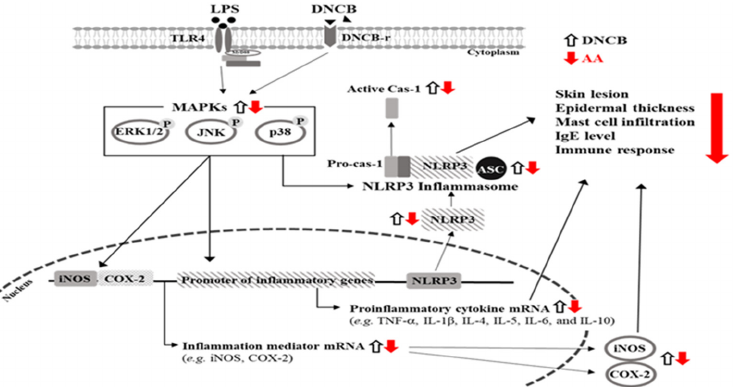
Figure 15. Suggested mechanism for mitigation effects of AA in AD. In this scheme, the treatment of AD is thought to ameliorate the enhancement of skin thickness, dermatitis score, immune organ weight, IgE concentration, and mast cell infiltration through the regulation of iNOS-induced COX- 2 mediated pathway and transcription of inflammatory cytokines. Abbreviations: DNCB, 2,4-dini- trochlorobenzene; LPS, lipopolysaccharide; AA, abietic acid; iNOS, inducible nitric oxide synthase; COX-2, cyclooxygenase-2; MAPK, mitogen-activated protein kinase; ERK, extracellular signal-reg- ulated kinase; JNK, c-Jun N-terminal kinase; TNF- α , tumor necrosis factor alpha; IL, interleukin. Supplementary Materials: The following are available online at www.mdpi.com/xxx/s1, Table S1. RSM design to maximize the extraction yield and improve the purity of AA from rosin, Table S2: Primer sequences for RT-qPCR analyses, Figure S1: Cell viability assay to determine the optimal AA concentration, Figure S2: Cell viability assay to determine the optimal LPS concentration, Figure S3: The NO concentration was used to determine the optimal concentration of LPS.